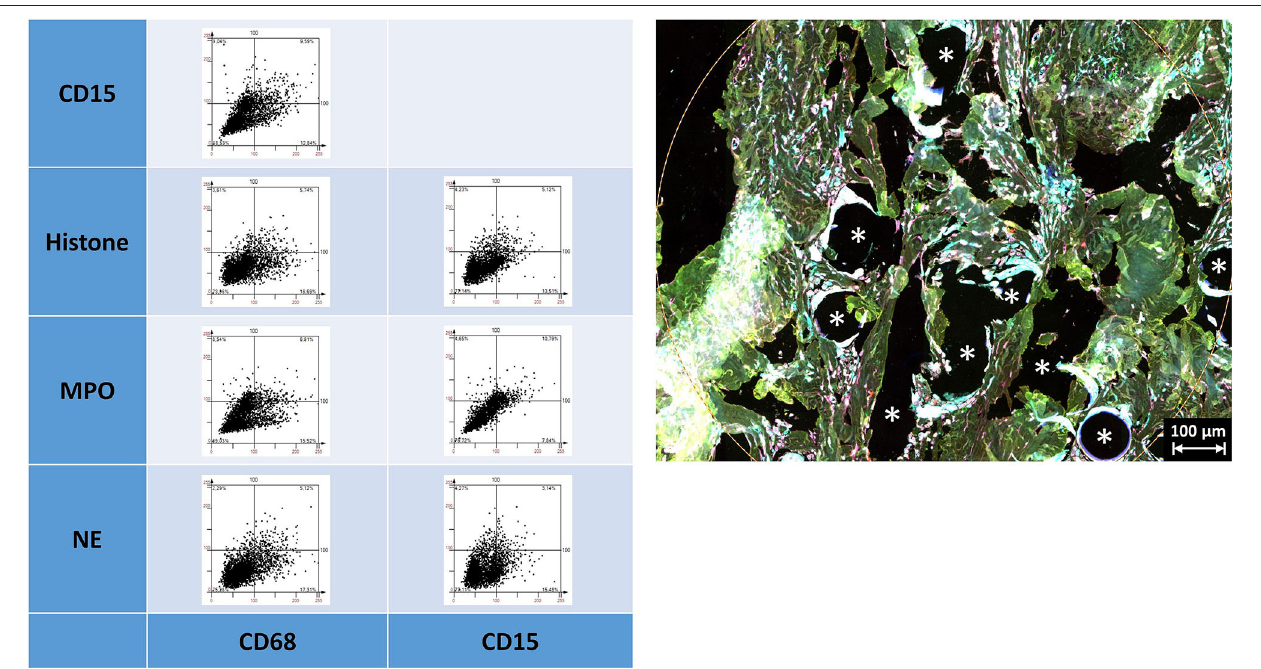
FIGURE 7 | Examples of linear scatter plots from neutrophil panel. Scatter plots of mean cellular intensities of two markers in a 1 mm 2 ROI placed around PP mesh fibers. The lines in the scatter plot mark the cut-off value 100. Cytometric analysis was performed with StrataQuest 7. Asterisks mark fiber locations.